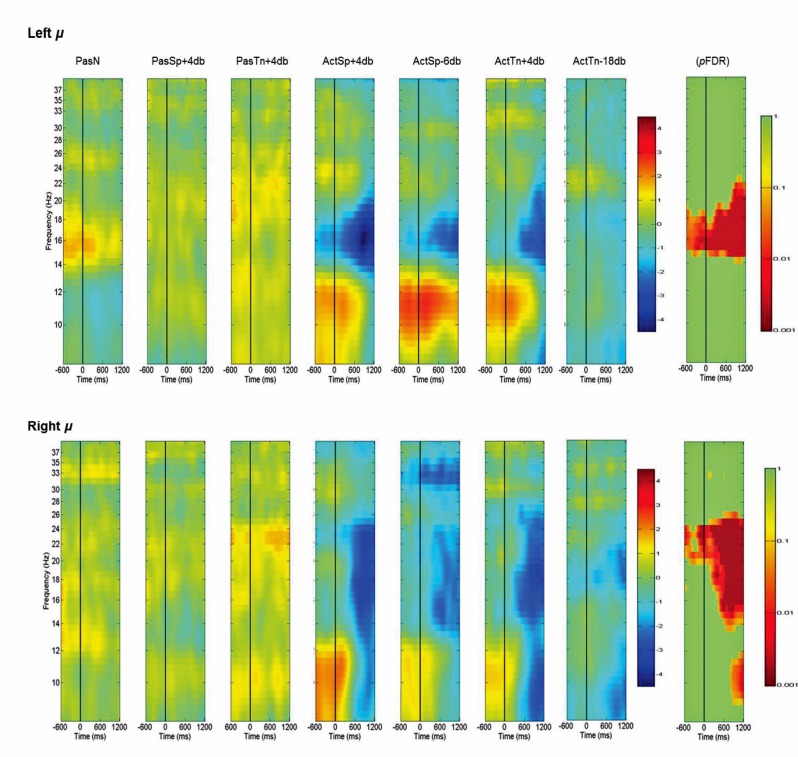
Mean left and right hemisphere µ time-frequency ERSPs (event-related spectral perturbations).ERSPs are scaled in the same root-mean-square decibel units as a function of condition (1×7) and random effects analysis indicating significant values in the traditional beta (13–30 Hz) and alpha ranges (8–13 Hz). Non-significant values are colored green, with significant values shown in orange and red. Event-related decreases in spectral power are indicated in blue (−4.5) and increases are indicated in red (4.5).